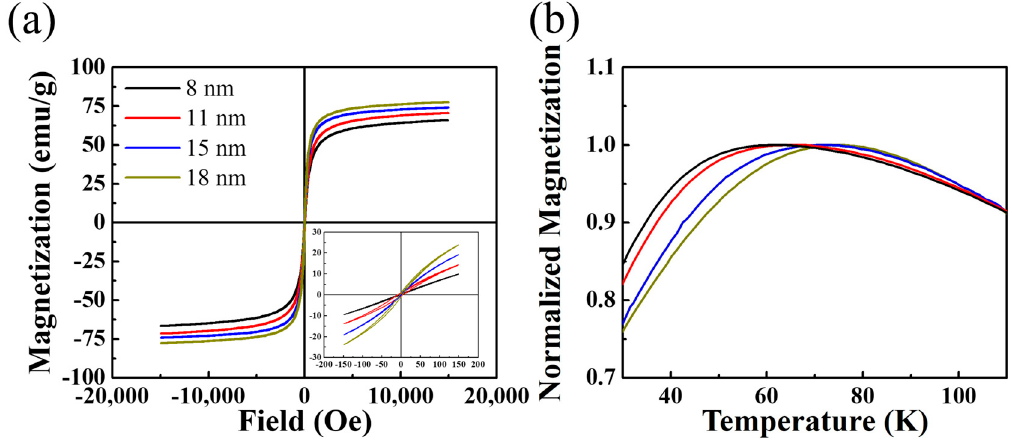
Figure 2. Magnetic properties of iron oxide nanoparticles synthesized with alkaline metal reagent ( a ) Superimposed room temperature field-dependent magnetization loop of different sizes of magnetite nanoparticles. The inset in ( a ) shows minor M-H hysteresis curve; ( b ) Temperature-dependent normalized magnetization plot under 50 Oe for magnetite nanoparticles of different size under zero-field cooling (ZFC) magnetization.